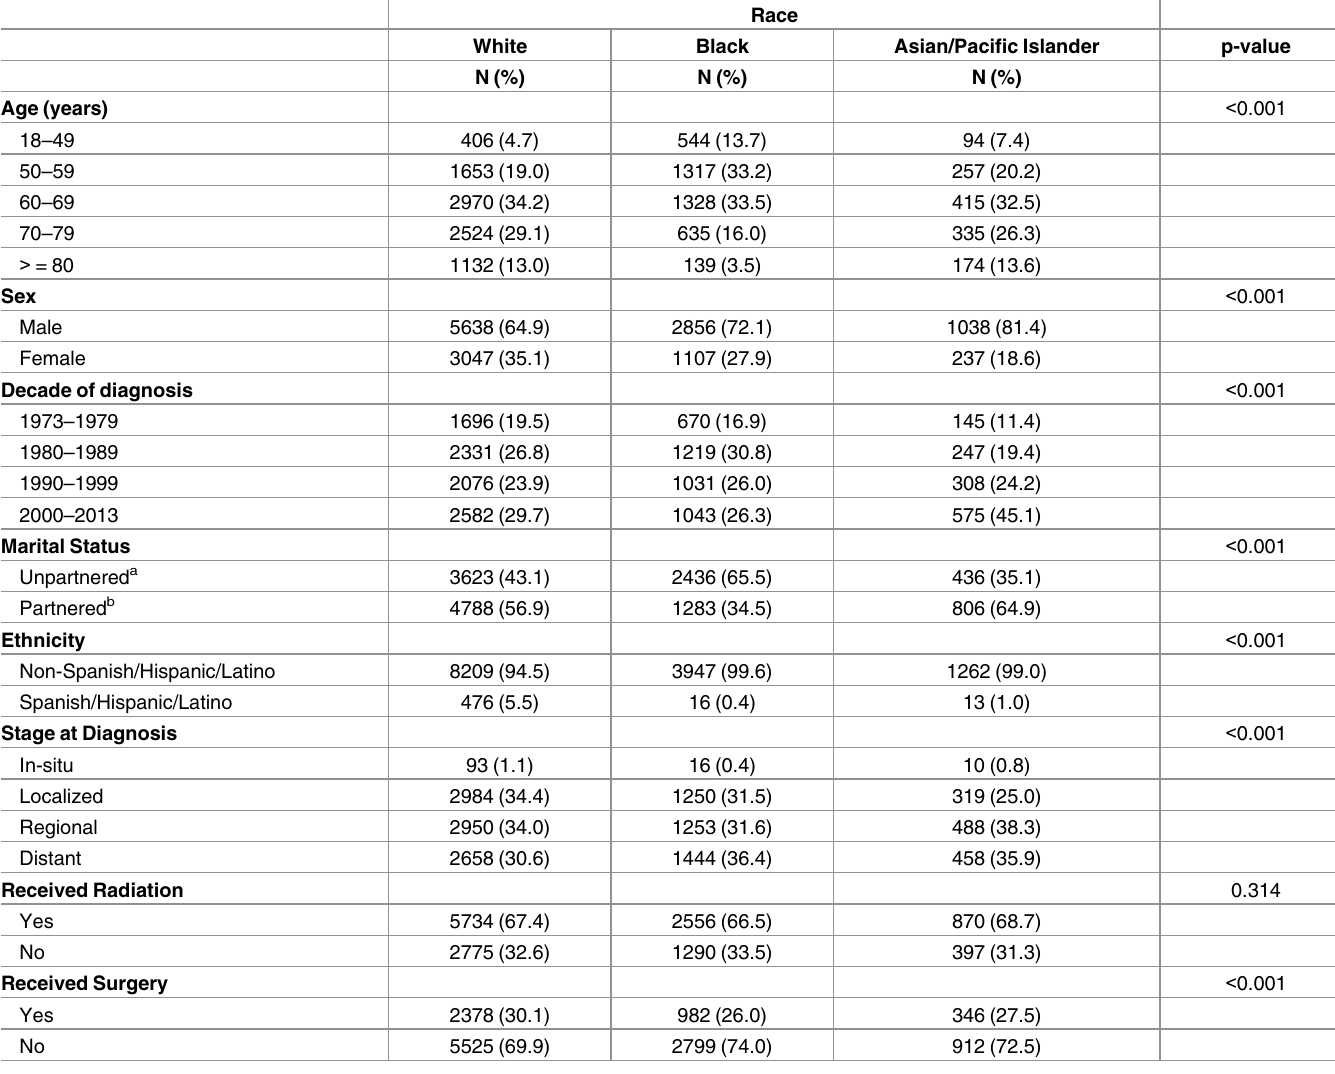
Table 1. Demographic and clinical characteristics, by race, of adult patients in the SEER registry diagnosed with esophageal squamous cell carci- noma,